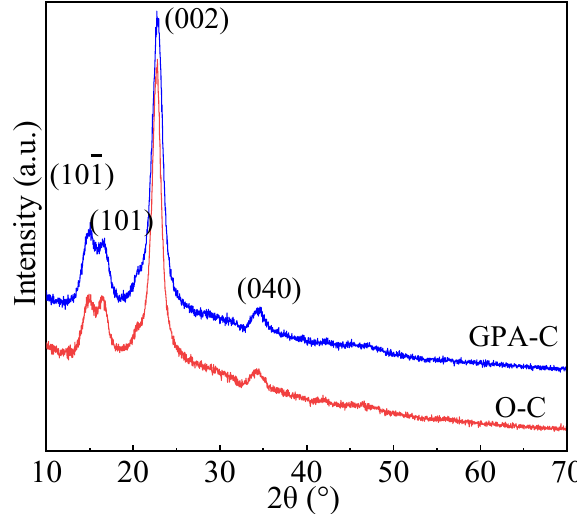
Figure 6. XRD spectrum of fabrics.